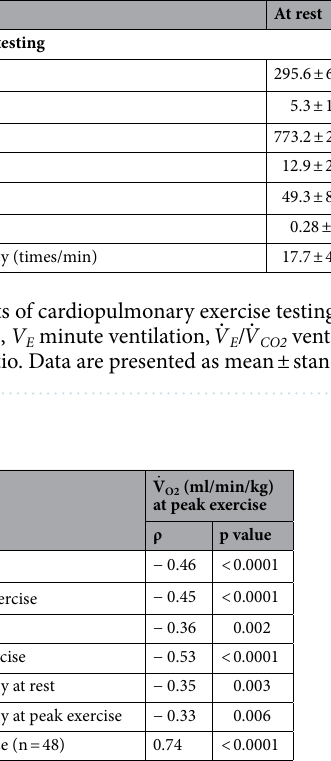
˙ VO 2 at peak exercise and other CPET parameters and the 6-min